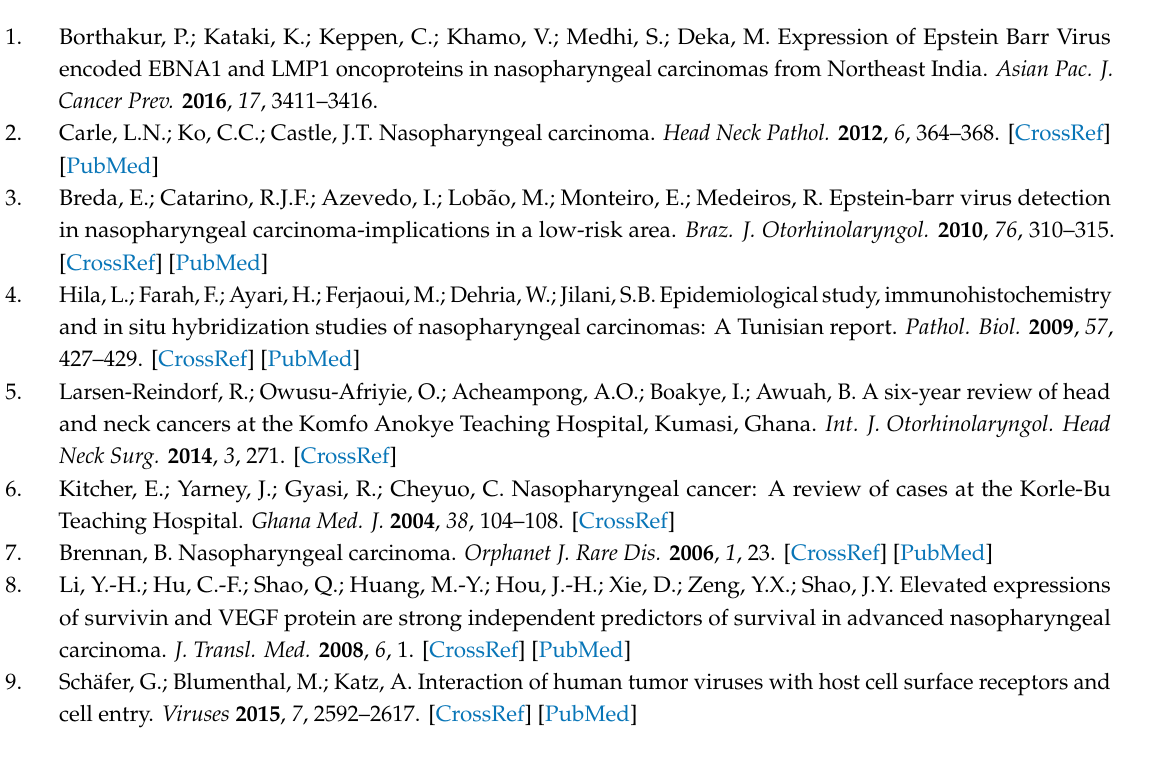
Figure S1: Gel electropherogram of EBV EBNA-1 PCR amplification, Figure S2: Gel electropherogram of EBV